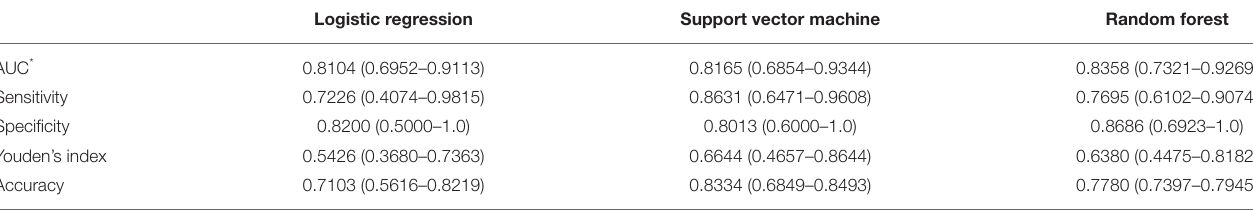
TABLE 3 | Comparison between different classifiers.